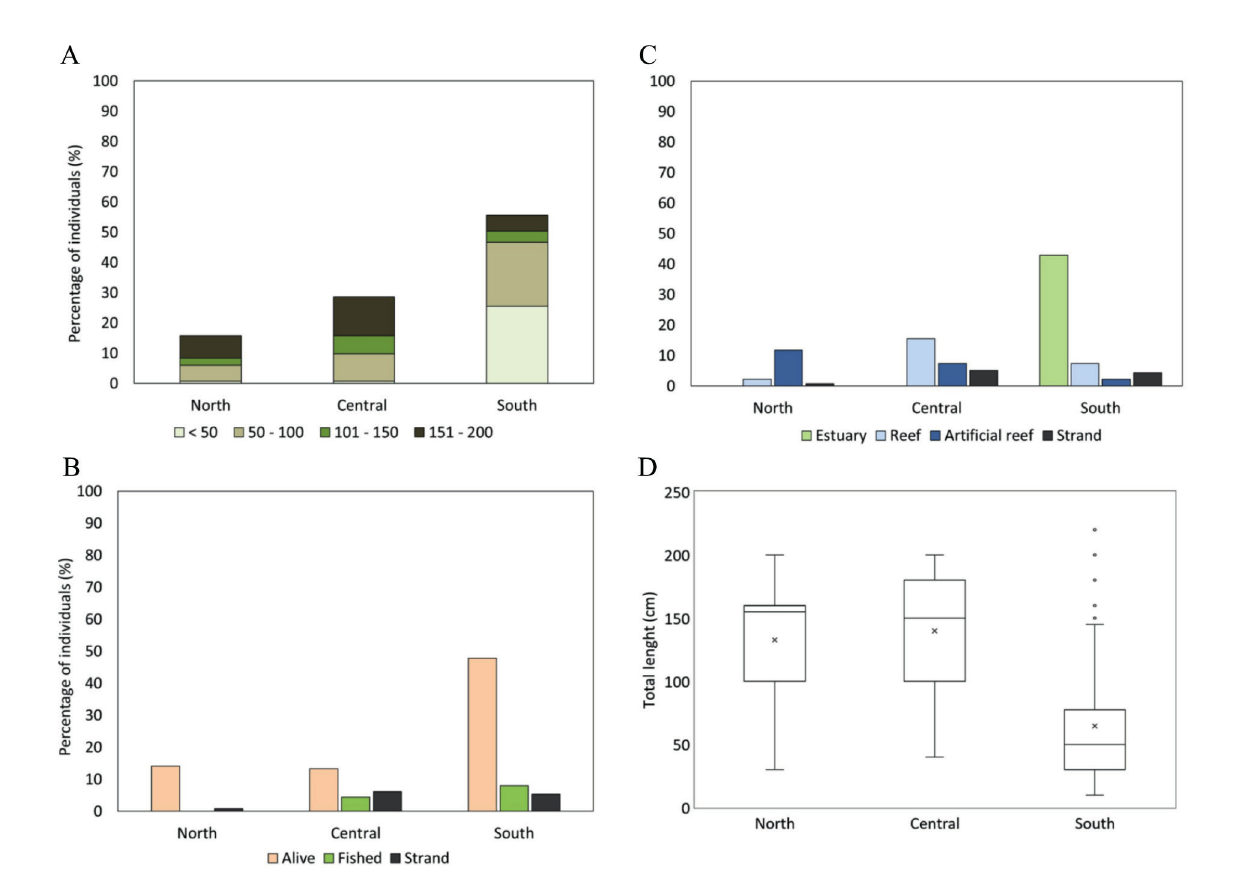
FIGURE 6 | A. Percentage of Atlantic Goliath Grouper (AGG) Epinephelus itajara registered along the coast of Alagoas, arranged in length category and; B. Percentage of individuals registered alive and dead (fished and stranded), along the division of the coast of Alagoas. C. Percentage of AGG recorded along the coast of Alagoas, distributed by habitats. Stranded animals also make up the graph. D. Distribution of AGG with estimated TL, arranged along the coast of Alagoas. Boxplots present the maximum and minimum limits (upper and lower rush). In the interquartile range are the third and first quartiles at the ends, median and mean (x) of the total length of the subjects. Color- differentiated total length (TL) categories and separated by